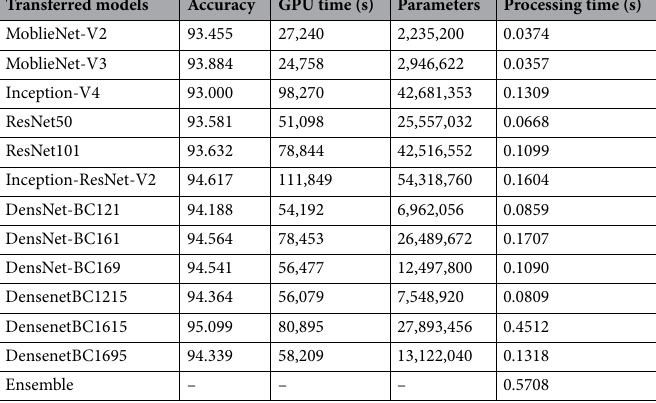
N correctly classified images N